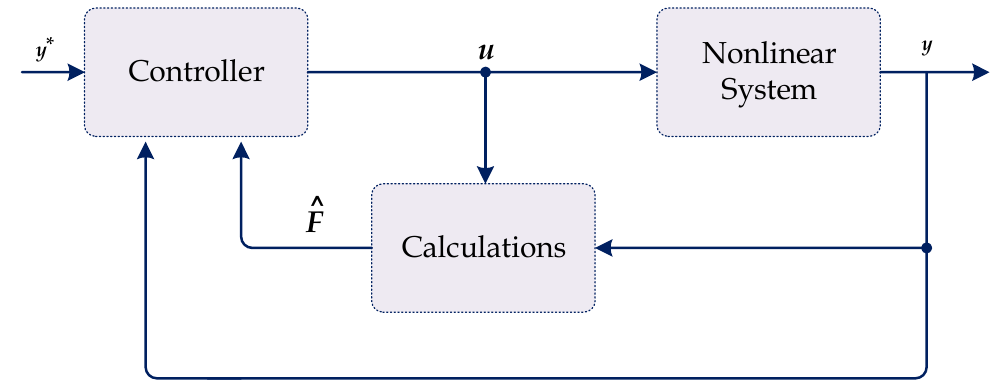
Figure 3. Structure of the ultra-local model.